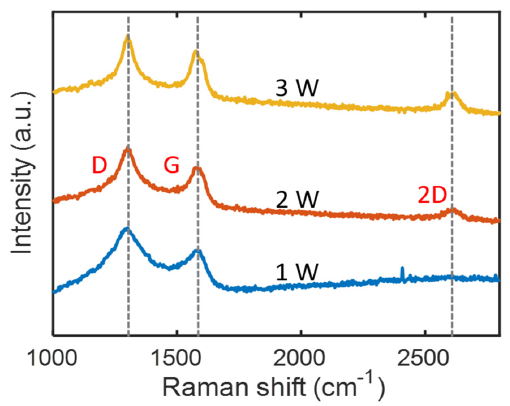
Figure 6. Raman spectra of laser-pyrolyzed microsupercapacitor electrodes produced at 1, 2, and 3 W.